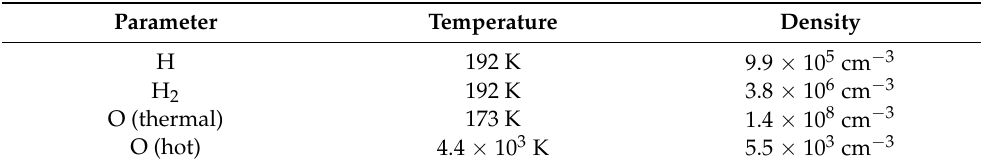
Table 2. Parameters of the exosphere model at the critical altitude 1 .